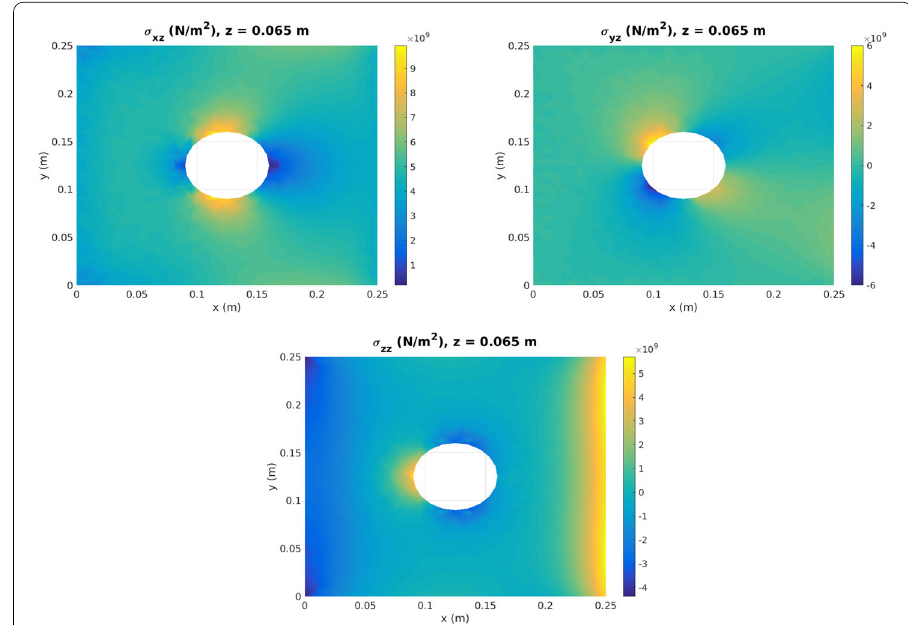
Fig. 9 Out-of-plane stress tensor components in the z = 65 mm plane using 3D FEM